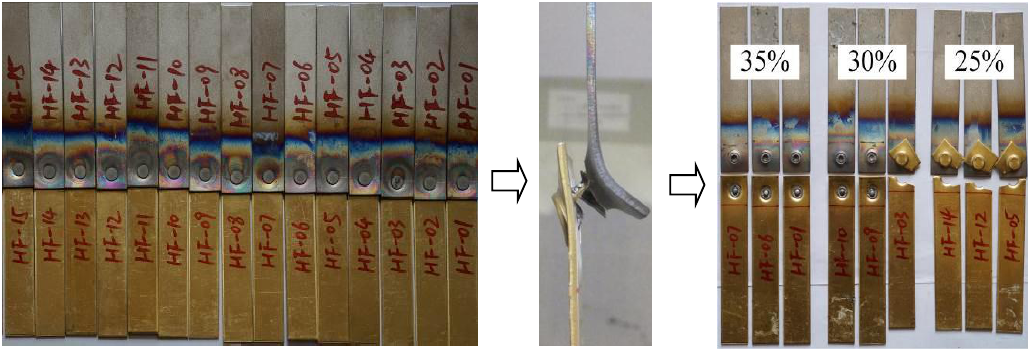
Figure 6. Fatigue process of the STH joints.